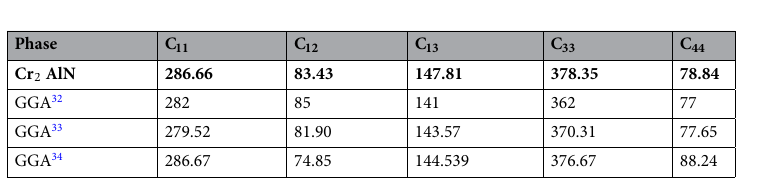
Figure 5. Electronic properties of the hexagonal phase of Cr 2 AlN. ( a ) The electronic band structure, ( b ) the total and partial electronic local density of states, and ( c ) the Fermi surface.